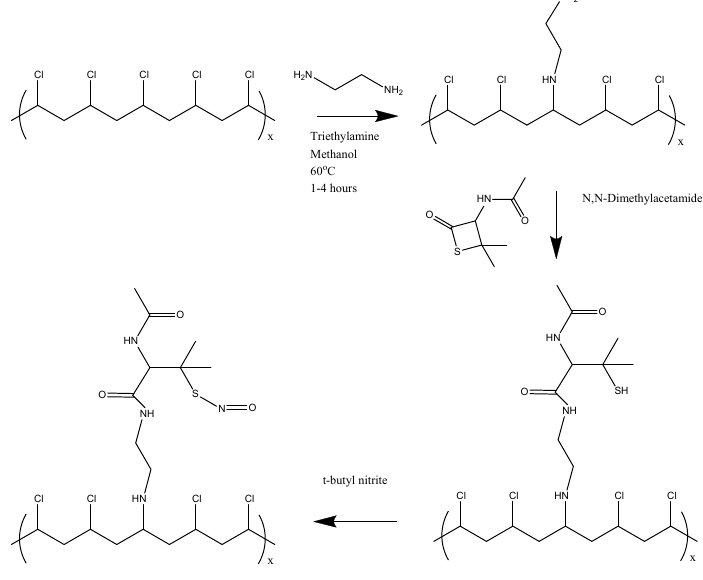
Figure 1. Synthesis route of the nitric oxide-releasing polymer